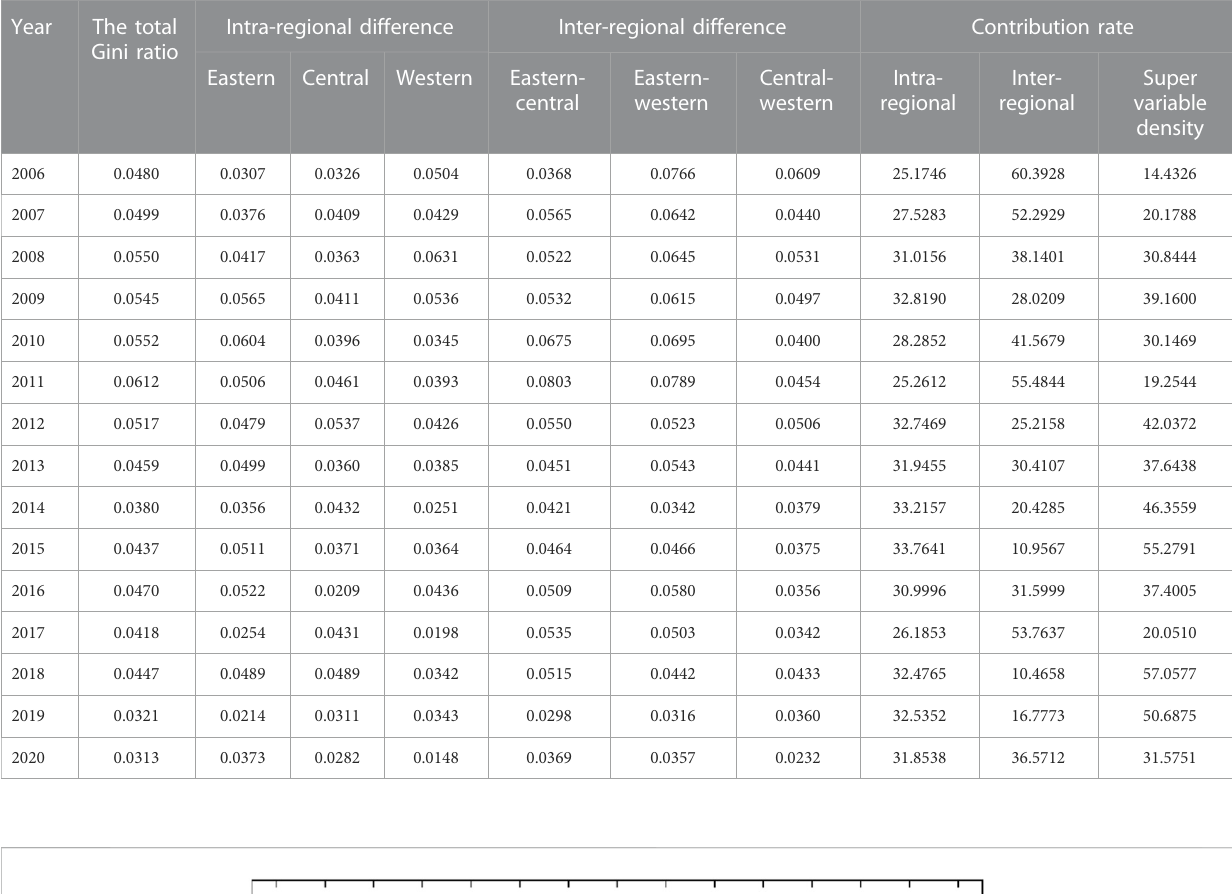
TABLE 3 Regional difference and contribution rate of green development quality in the construction industry.